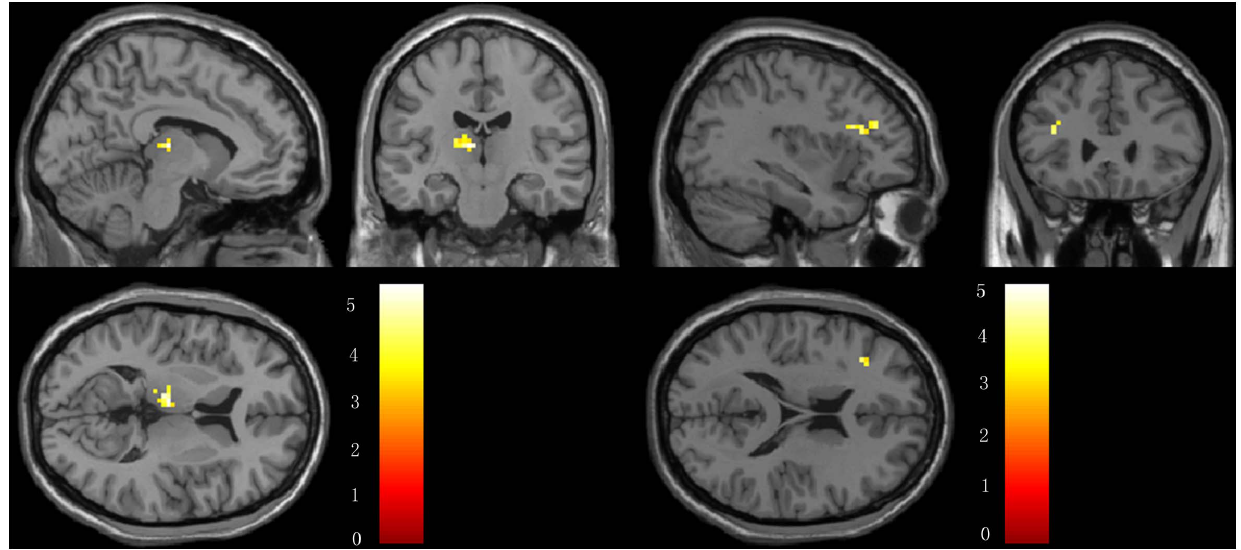
Figure 9. Brain regions showing altered connectivity to right hippocampus in control group after acupuncture comparing to before acupuncture. The left thalamus, MFG and insula showed increased connectivity to right hippocampus in controls after acupuncture. Left in picture is left in the brain. The color scale represents t values.